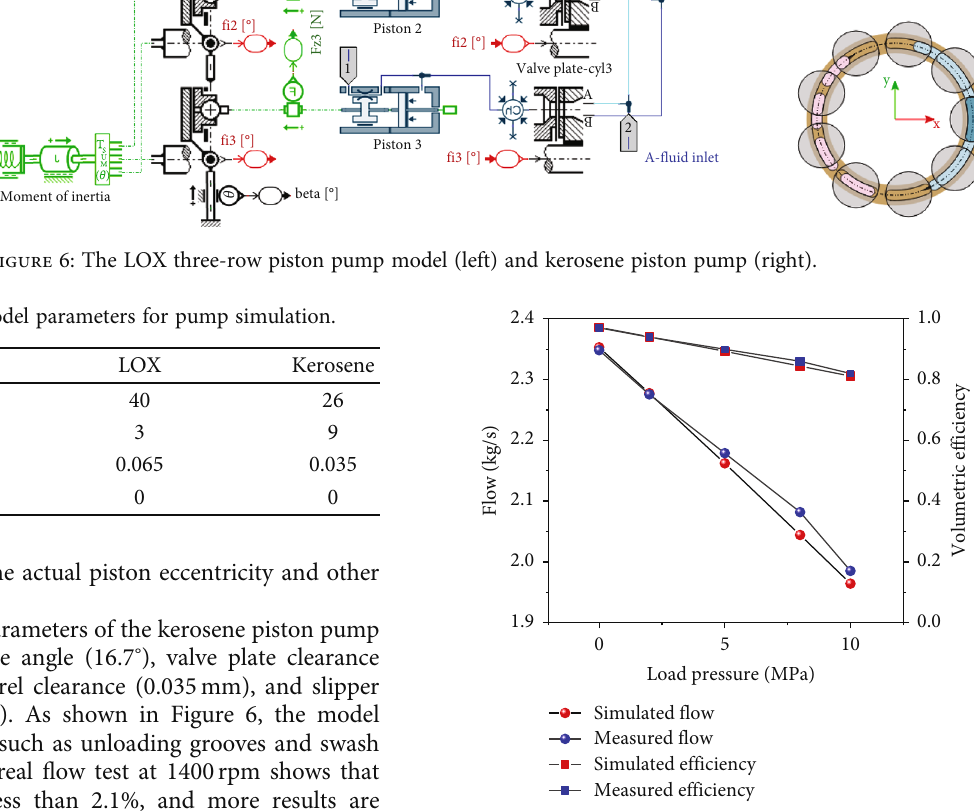
Figure 7: The veri fi cation of kerosene piston pump